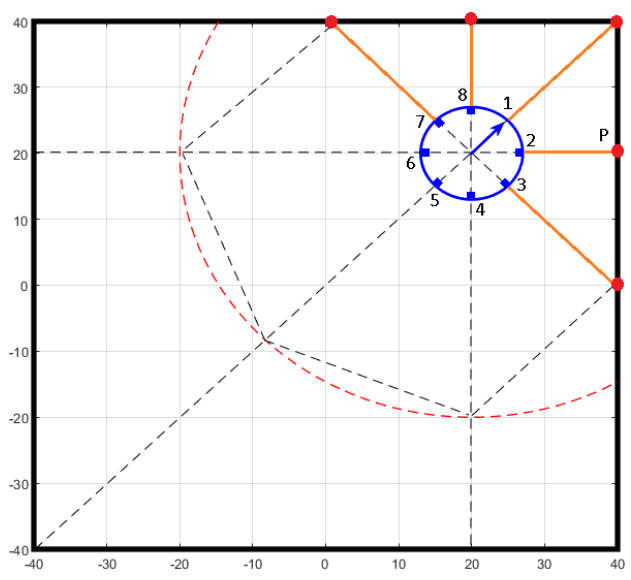
Figure 11. Distance from the sensors to known obstacles (walls).